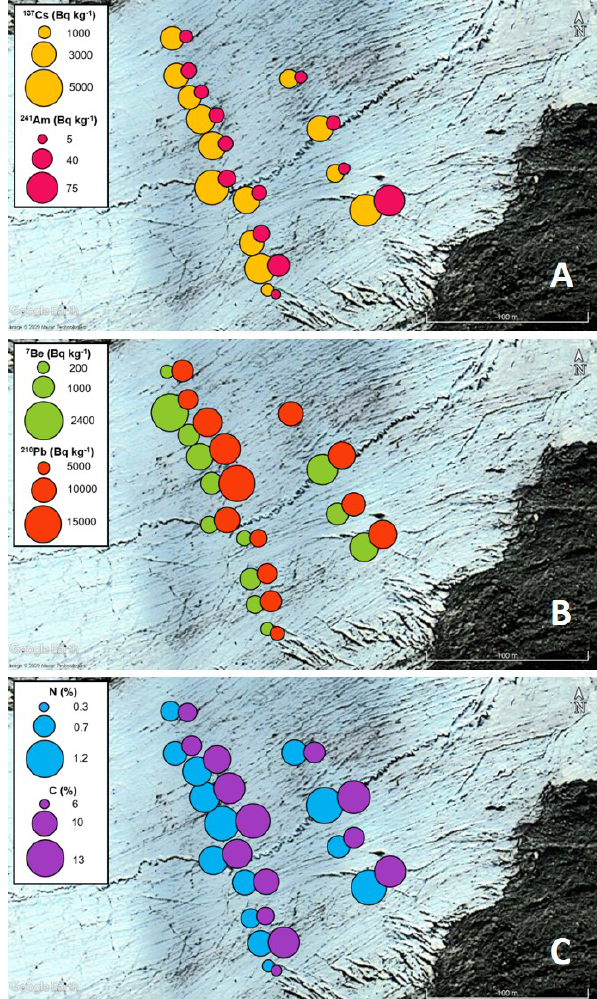
Figure 2. Spatial variability of selected anthropogenic (A) and nat- ural (B) radionuclide activities and the C and N content (C) of cry- oconite on Isfallsglaciären. The sampling points for cryoconite sam- ples G1 to G14 (see Fig. 1C) are centred beneath the yellow, green, and blue circles in (A–C) respectively. Note that 7 Be was not de- tected above the minimum detectable amount in sample G14 (B) . Imagery source: Google Earth, 67 ◦ 54 (cid:48) 55.25 (cid:48)(cid:48) N, 18 ◦ 35 (cid:48) 32.13 (cid:48)(cid:48) E (image from 8 October 2013) © Google